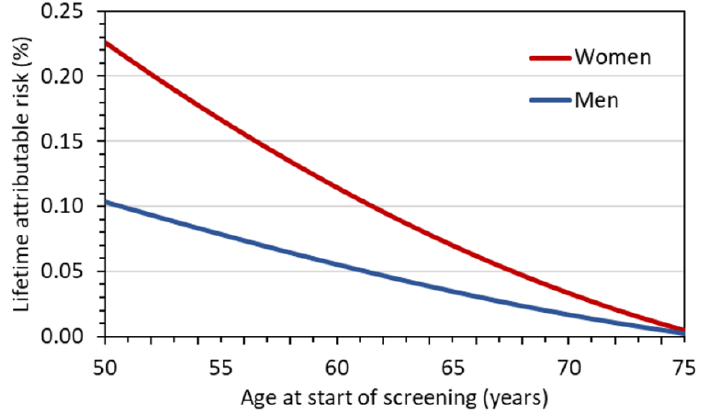
Figure 3. Lifetime attributable risks, LAR , (cancer incidence) as a function of age at first screening examination assuming annual LDCT screening up to age 75 for a representative LDCT protocol with CTDI vol = 1 mGy.